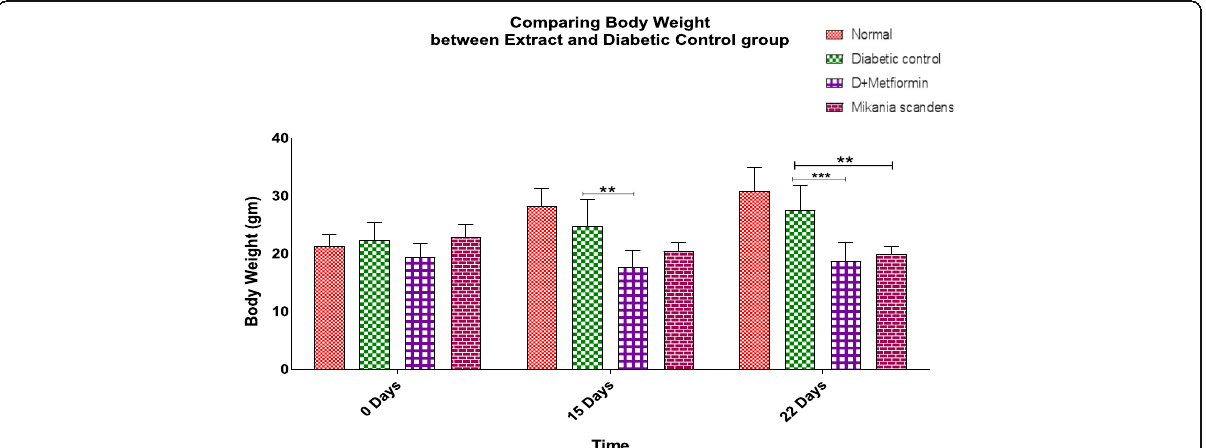
Fig. 1 Comparing body weight among diabetic control, Metformin HCL and Mikania scandens animal group. Significantly different ( p < 0.05) from the diabetic control. Data was analyzed by two way ANOVA followed by Scheffe ’ s post-hoc